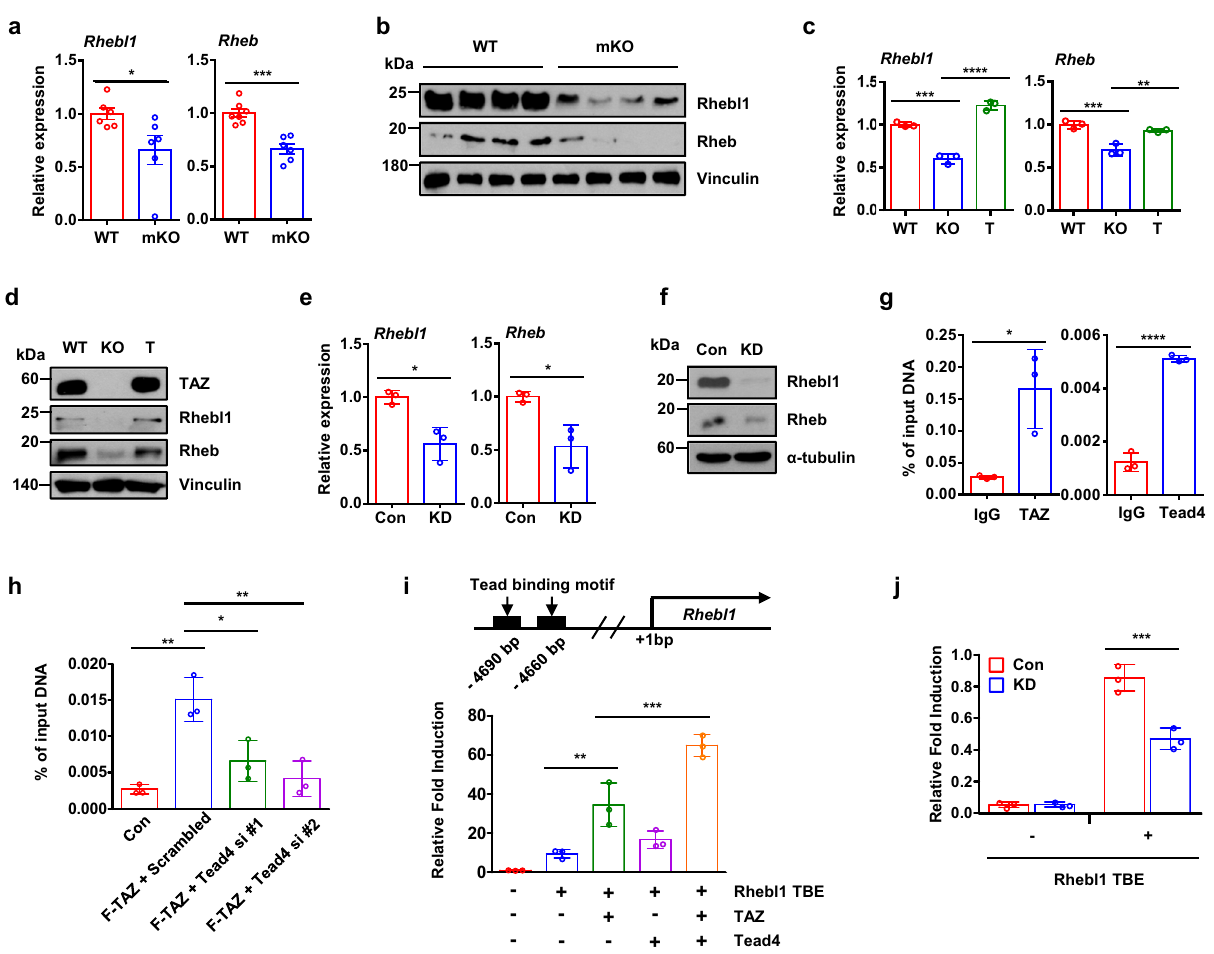
Fig. 3 TAZ induces the expression of Rheb and Rhebl1 to promote the initiation of the translation of Tfam mRNA. a RNA was isolated from the gastrocnemius muscle of wild-type (WT) and muscle-speci fi c TAZ knockout (mKO) mice, and the transcript levels of Rheb and Rhebl1 were assessed using quantitative reverse transcription (qRT)-PCR; n = 6 (left), n = 7 for WT mice, and n = 6 for mKO mice (right) ( Rhebl1 ; * p = 0.0426, Rheb ; *** p = 0.0002). b Protein derived from the gastrocnemius muscle of WT and mKO mice was analysed via immunoblotting to determine the Rheb and Rhebl1 protein levels. Vinculin was used as the loading control. c The expression of Rheb and Rhebl1 was assessed using qRT-PCR in WT, TAZ knockout (KO), and TAZ-rescued (T) mouse embryonic fi broblasts (MEF). The experiment was performed in triplicate ( Rhebl1 ; *** p = 0.0001 for WT vs. KO, **** p < 0.0001 for KO vs. T, Rheb ; *** p = 0.0007 for WT vs. KO, ** p < 0.003 for KO vs. T). d Protein from WT, KO, and T MEF was analysed via immunoblotting to detect TAZ, Rheb, and Rhebl1. Vinculin was used as the loading control. e RNA was isolated from control (Con) and C2C12 myotubes with TAZ knockdown (KD). Rhebl1 and Rheb expression was assessed using qRT-PCR. The experiment was performed in triplicate ( Rhebl1 ; * p = 0.0105, Rheb ; * p = 0.0171). f Protein from the Con and TAZ KD C2C12 myotubes was analysed via immunoblotting to detect the Rhebl1 and Rheb protein levels. Alpha-tubulin was used as the loading control. g Recruitment of TAZ (left) or TEAD4 (right) to the TAZ binding element (TBE) of the Rhebl1 enhancer was veri fi ed using chromatin immunoprecipitation (ChIP)-quantitative PCR (qPCR). Sheared chromatin from the gastrocnemius muscle of WT mice was ChIPed with the anti-TAZ or anti-TEAD4 antibody. ChIPed DNA was analysed via qPCR using primers spanning the TBE region. Immunoglobulin G (IgG) was used as the ChIP control. The experiment was performed in triplicate (TAZ; * p = 0.0183, Tead4; *** p < 0.0001). h TEAD4 was depleted by two different siRNAs in FLAG-tagged TAZ (F-TAZ)-overexpressing C2C12 myoblasts, and ChIP was performed using an anti-FLAG antibody. ChIPed DNA was assessed via qPCR using a primer set covering the TBE region. Empty vector-transduced cells were used as ChIP controls. The experiment was performed in triplicate (Con vs. F- TAZ + Scrambled; ** p = 0.0011, F-TAZ + Scrambled vs. F-TAZ + Tead4 si #1; * p = 0.0112, F-TAZ + Scrambled vs. F-TAZ + Tead4 si #2; ** p = 0.0025). i Schematic descri p tion of Rhebl1 cis-regulatory element regulated by TAZ-TEAD4. The transcriptional activity of the Rhebl1 TBE was con fi rmed using a luciferase reporter gene assay. Approximately 500 bp of the genomic region covering the Rhebl1 TBE were cloned into a pGL3 basic luciferase reporter plasmid together with the promoter region of Rhebl1 ( Rhebl1 TBE-Luc). Rhebl1 TBE-Luc was transfected into HEK293T cells with TAZ and/or TEAD4, and a reporter gene assay was performed 24 h after transfection. The experiment was performed in triplicate ( Rhebl1 TBE vs. Rhebl1 TBE + TAZ; ** p = 0.0033, Rhebl1 TBE + TAZ vs. Rhebl1 TBE + TAZ + Tead4; *** p = 0.0007). j Con and HEK293T cells with TAZ KD were transfected with Rhebl1 TBE-Luc. A luciferase reporter assay was performed 24 h after transfection. The experiment was performed in triplicate (*** p = 0.0002). For a , b , g 8 to 10-week- old mice were used. Data are presented as mean ± SEM for ( a ), and mean ± SD for ( c , e , g – j ). Statistical signi fi cance was analysed via two-sided t -test for ( a , e , g ) or one-way ANOVA with Tukey ’ s multiple comparison test for ( c , h , i ). For ( j ) two-way ANOVA with Sidak ’ s multiple comparison test was used. Representative data was shown and experiments were performed at least twice with similar results for ( b , d , f ). Source data are provided as a Source data fi